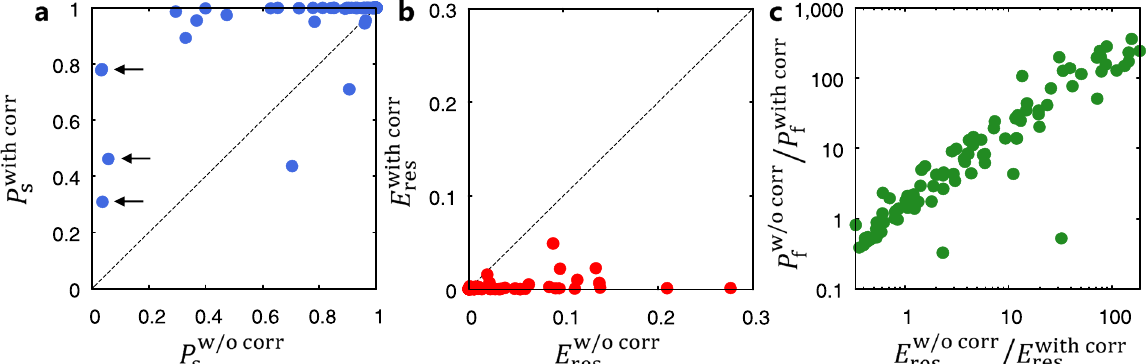
Fig. 3 Results for 100 random instances of the four-spin Ising problem. a Two-dimensional plot of success probabilities without and with the correction, P w = o corr and P with corr s